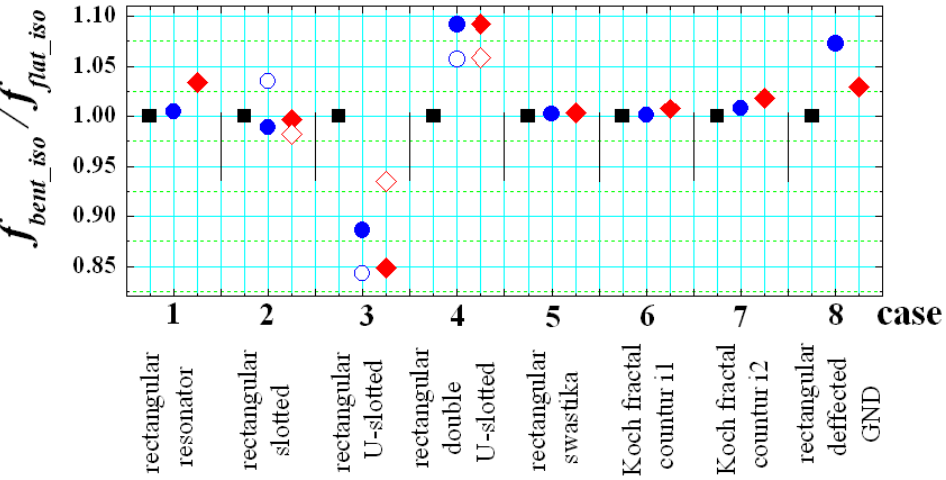
Figure 18. Simulated values of the ratio f bent_iso / f flat_iso between the resonance frequencies of the lowest-order mode in several planar resonance structures with dimensions 30 × 30 mm on isotropic substrates ( h s = 0.52; Δ A ε ~ 25%) (this ratio gives the pure effect of bending). The shapes of the considered structures are presented in Figures 19/20. The first column for each case corresponds to a flat structure, second—bent at α C = 8°; third—bent at α C = 12°; Solid and hollow points correspond to two mutually perpendicular orientations (V & H) of the structure during the bending (when this is possible).